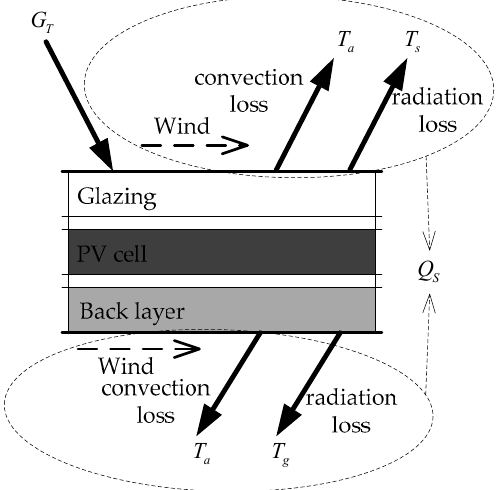
Figure 1. Schematic of the thermal processes of a photovoltaic (PV) cell.